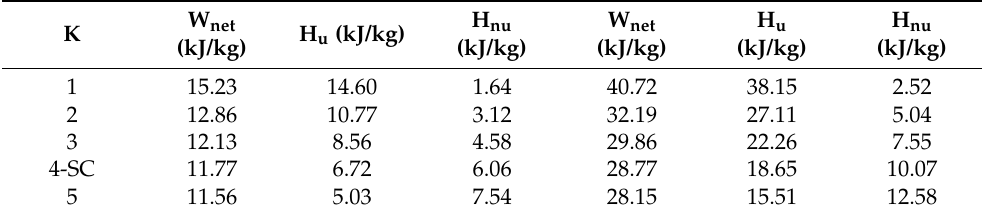
Table 3. Net power required, and the heat used and discarded considering a storage pressure of 20 bar: CO 2 (left); H 2